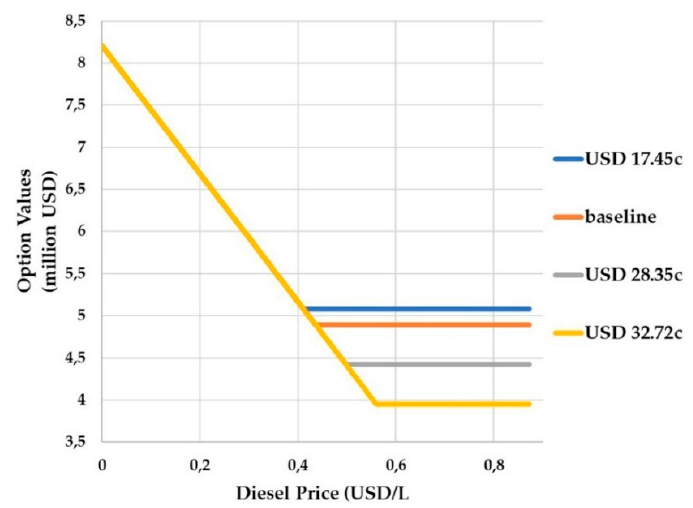
Figure 5. Option values at different electricity prices. Current electricity price = USD 22.20c/kWh; USD 17.45c reduces the electricity rate by PHP 2/kWh; USD 28.35c and USD 32.72c increase the electricity rate by PHP 3/kWh and PHP 5/kWh (USD 1 = PHP 45.85). Optimization results are tabulated in Supplementary Material Table